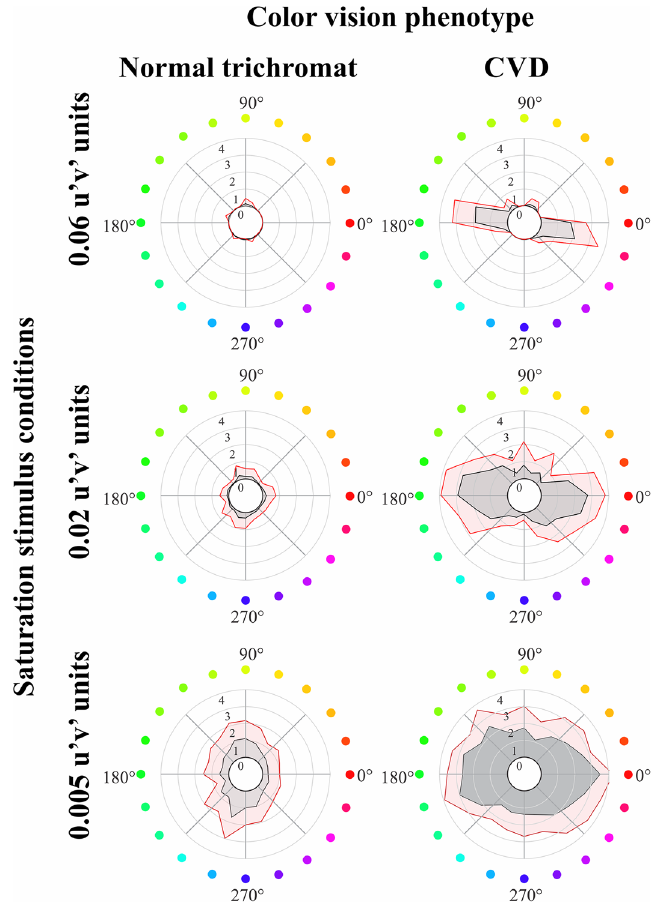
Figure 4. Mean values and dispersion for the polar representation of the chromatic discrimination in fixed saturation levels. (A) Normal trichromats. (B) Participants with CVD. Shaded gray areas represent the mean errors in the different chromatic vectors, while shaded red areas represent the mean errors plus 1 standard deviation in the different chromatic